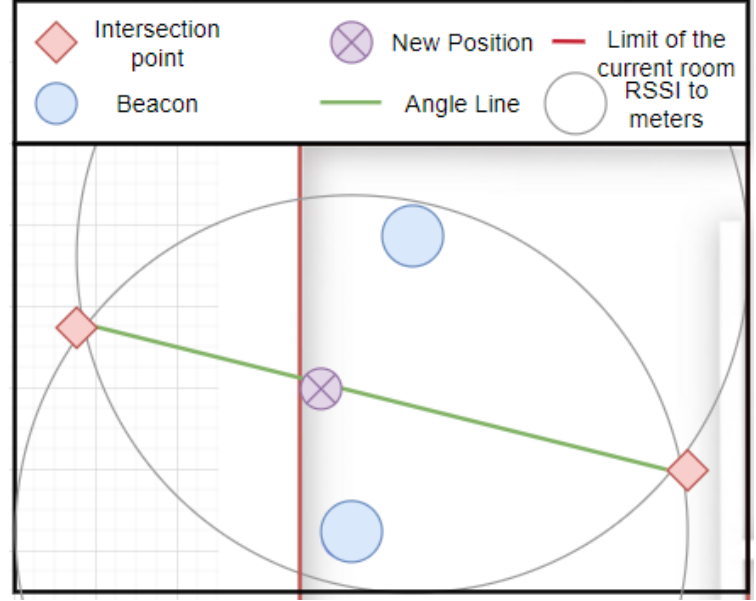
Figure 4. Recalibration of computed point based on room